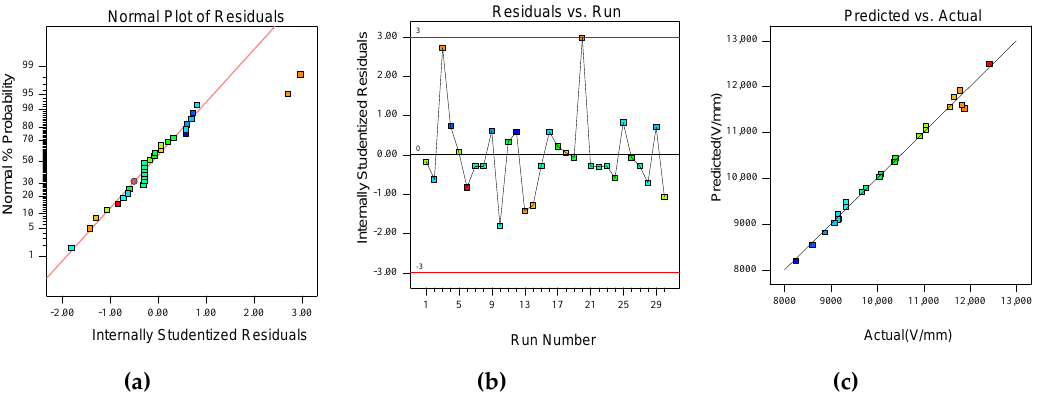
Figure 6. ( a ) Normal probability distribution of residuals; ( b ) residuals versus run; and ( c ) predicted values versus actual values.